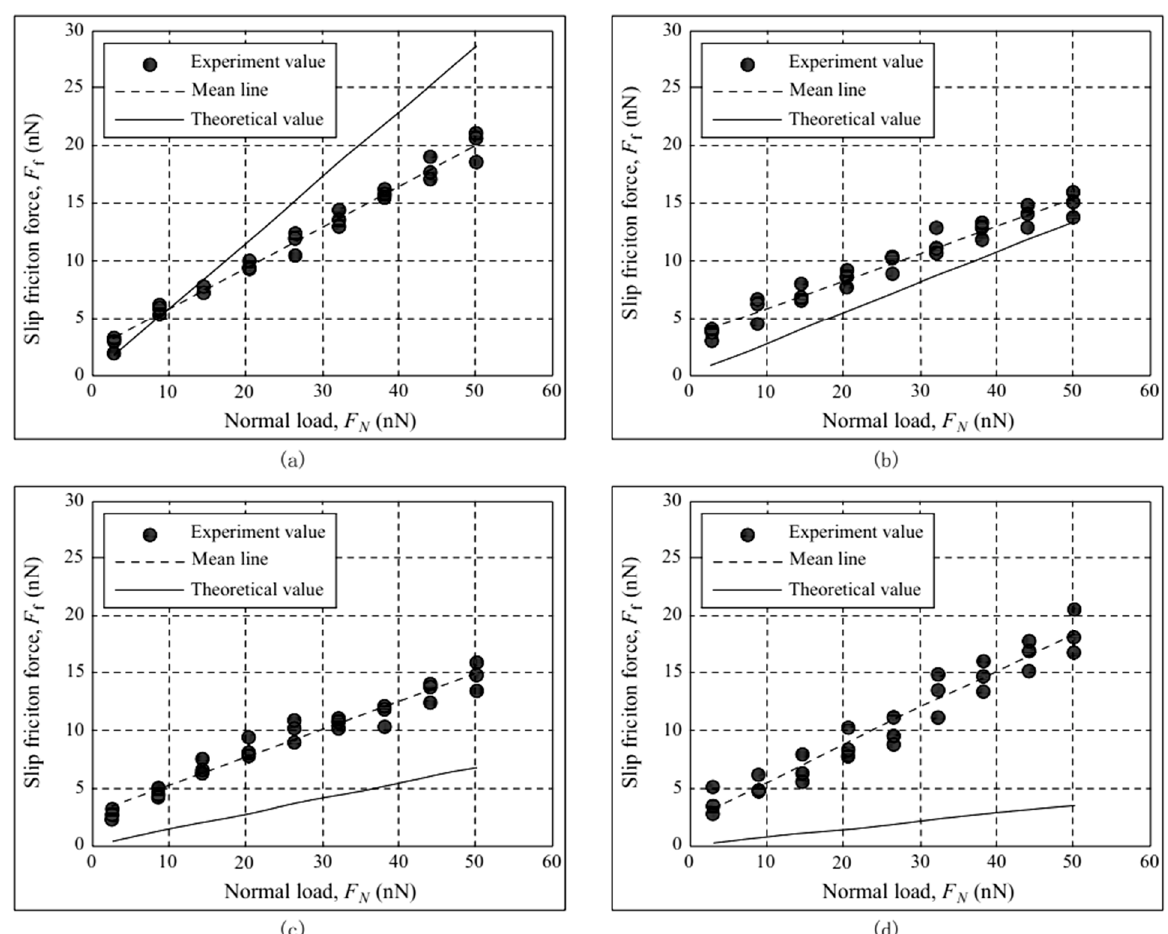
Figure 8. Dry friction experimental results with AFM: ( a ) sample 1, ( b ) sample 2, ( c ) sample 3, ( d ) sample 4.